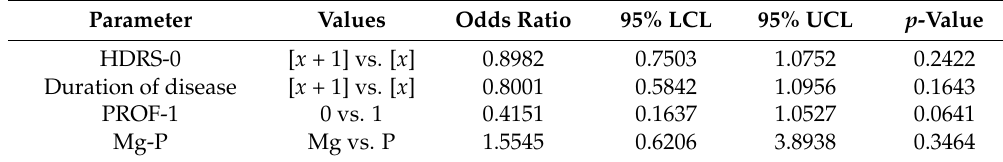
Table 2. Odds ratio values for the parameters evaluated in this model—the odds ratio for remission. Parameter Values Odds